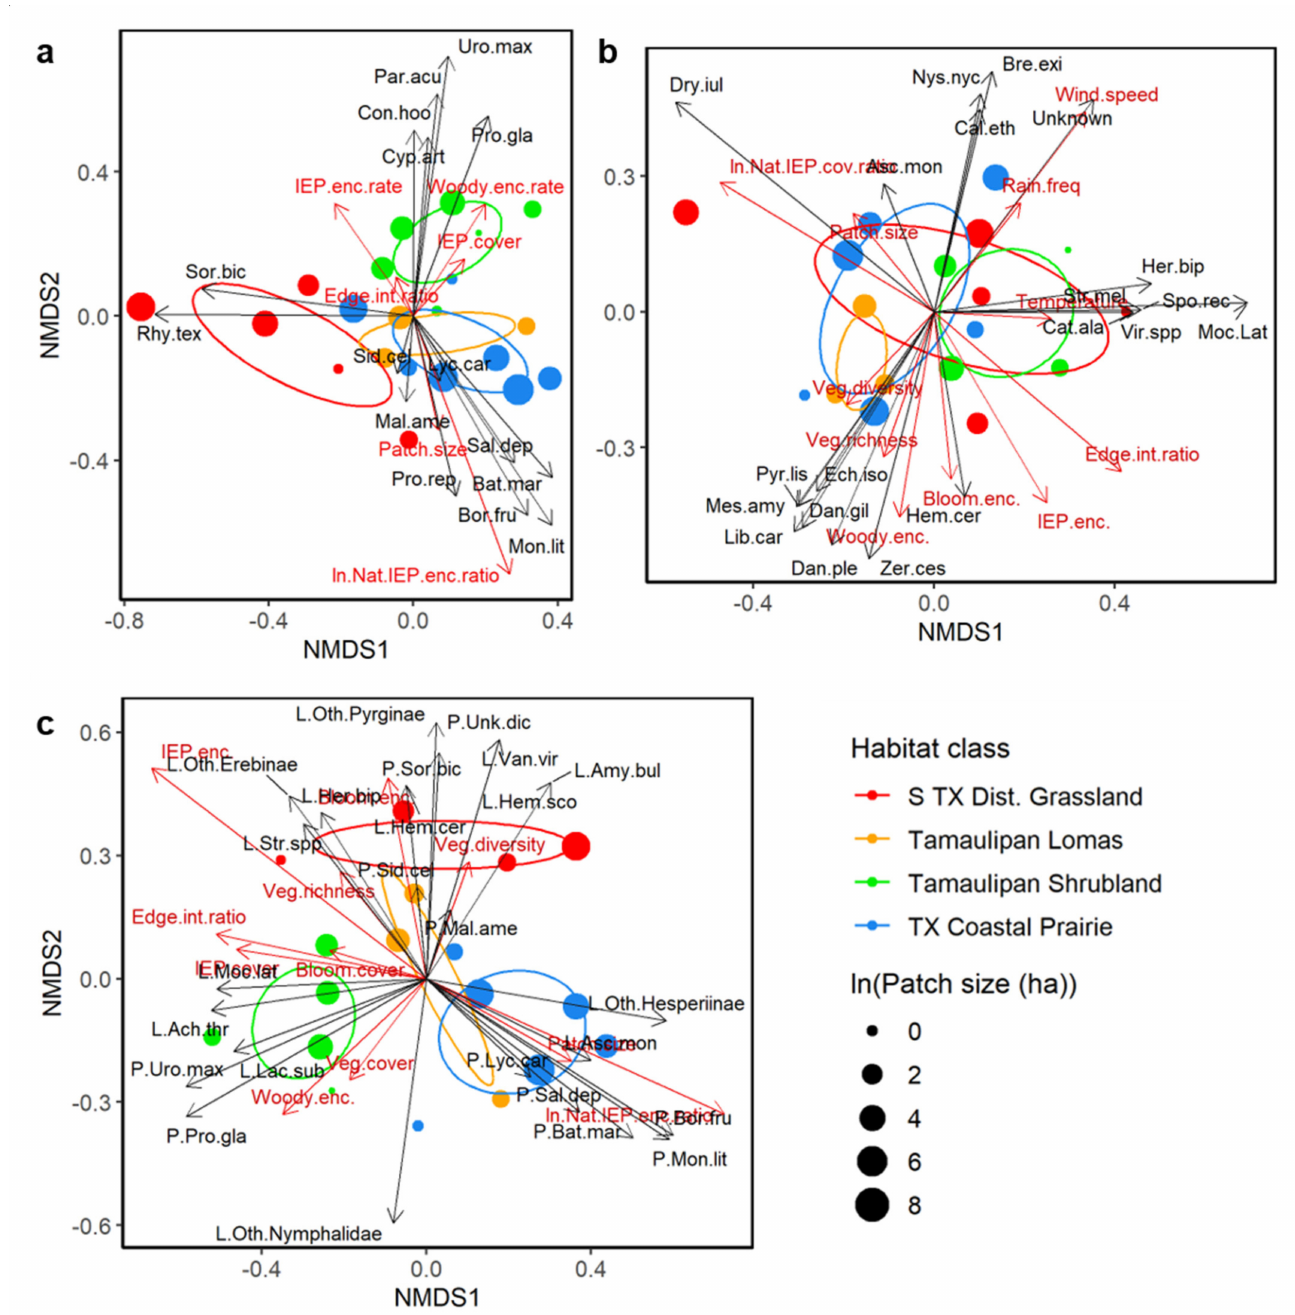
Figure 2. NMDS ordinations representing ( a ) plant, ( b ) Lepidoptera, and ( c ) combined (plant + Lep.) community com- positions and similarities among observed communities, which are represented as the position and spatial proximity of points, respectively. Points represent observed communities and correspond to individual study sites. The color and size of points denote habitat class and patch size, as depicted in the inset legend. Black vector arrows denote important species that drove separation among communities in the directions specified based on the observed prevalence of those species. Red vector arrows denote important continuous environmental factors associated with separation among communities in the directions specified. Colored ellipses represent the 95% confidence intervals around the theoretical average communities found in the four focal habitat classes. See Tables 4–6 (PerMANCOVA results) for additional information related to these ordination. Supplemental Figures S1–S3 depict the same ordinations in a larger, easier to read format. See Tables S1 and S2 for full species names and higher taxonomic information for plants and Lepidoptera, respectively, and for plant species nativity and pest